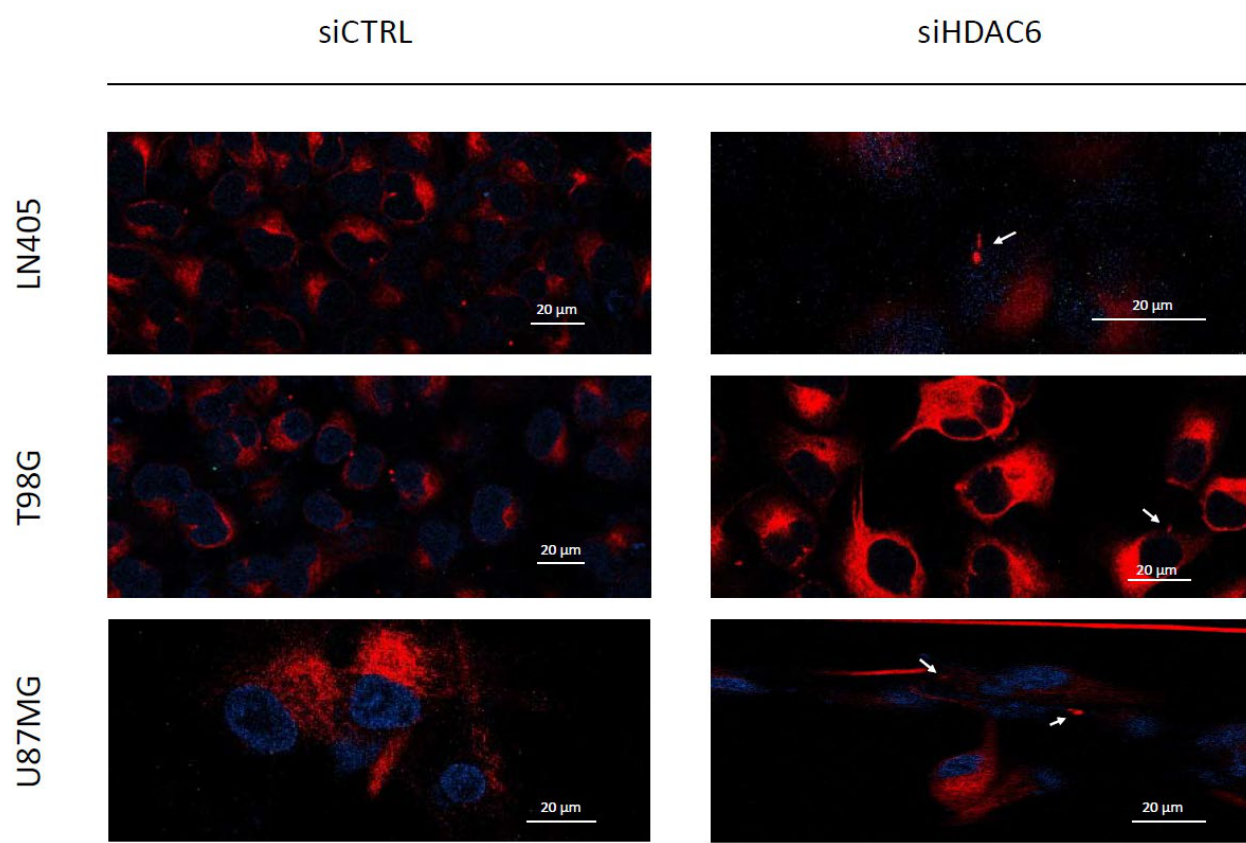
Figure 9. HDAC6 silencing restores a primary cilium-like structure in GBM cell lines. The white arrows mark the primary cilium-like structure in siHDAC6-treated human GBM cell lines. Photographs were taken at 63X.